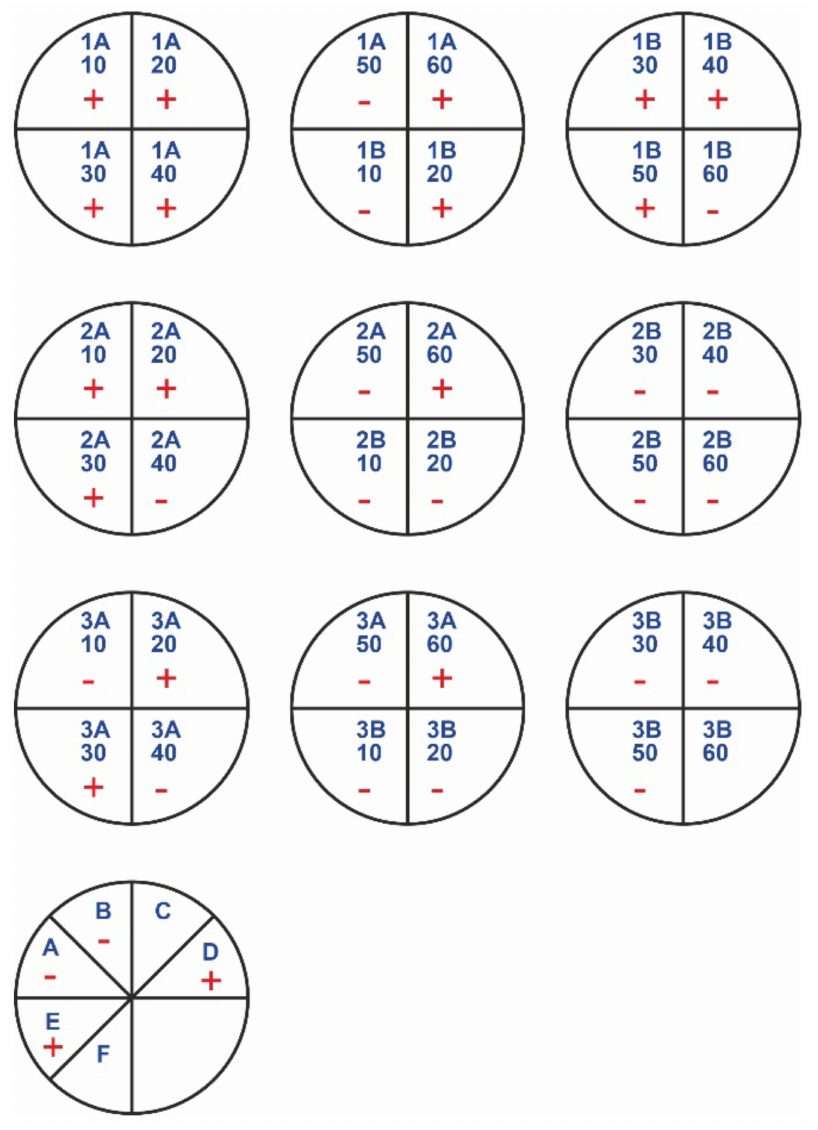
Figure 3. Growth of fungi in medium (SDA). Table 5. Effects of modification of chitosan-based materials on microbial growth for nonwovens modified using acetic acid solution in ethanol—procedure without